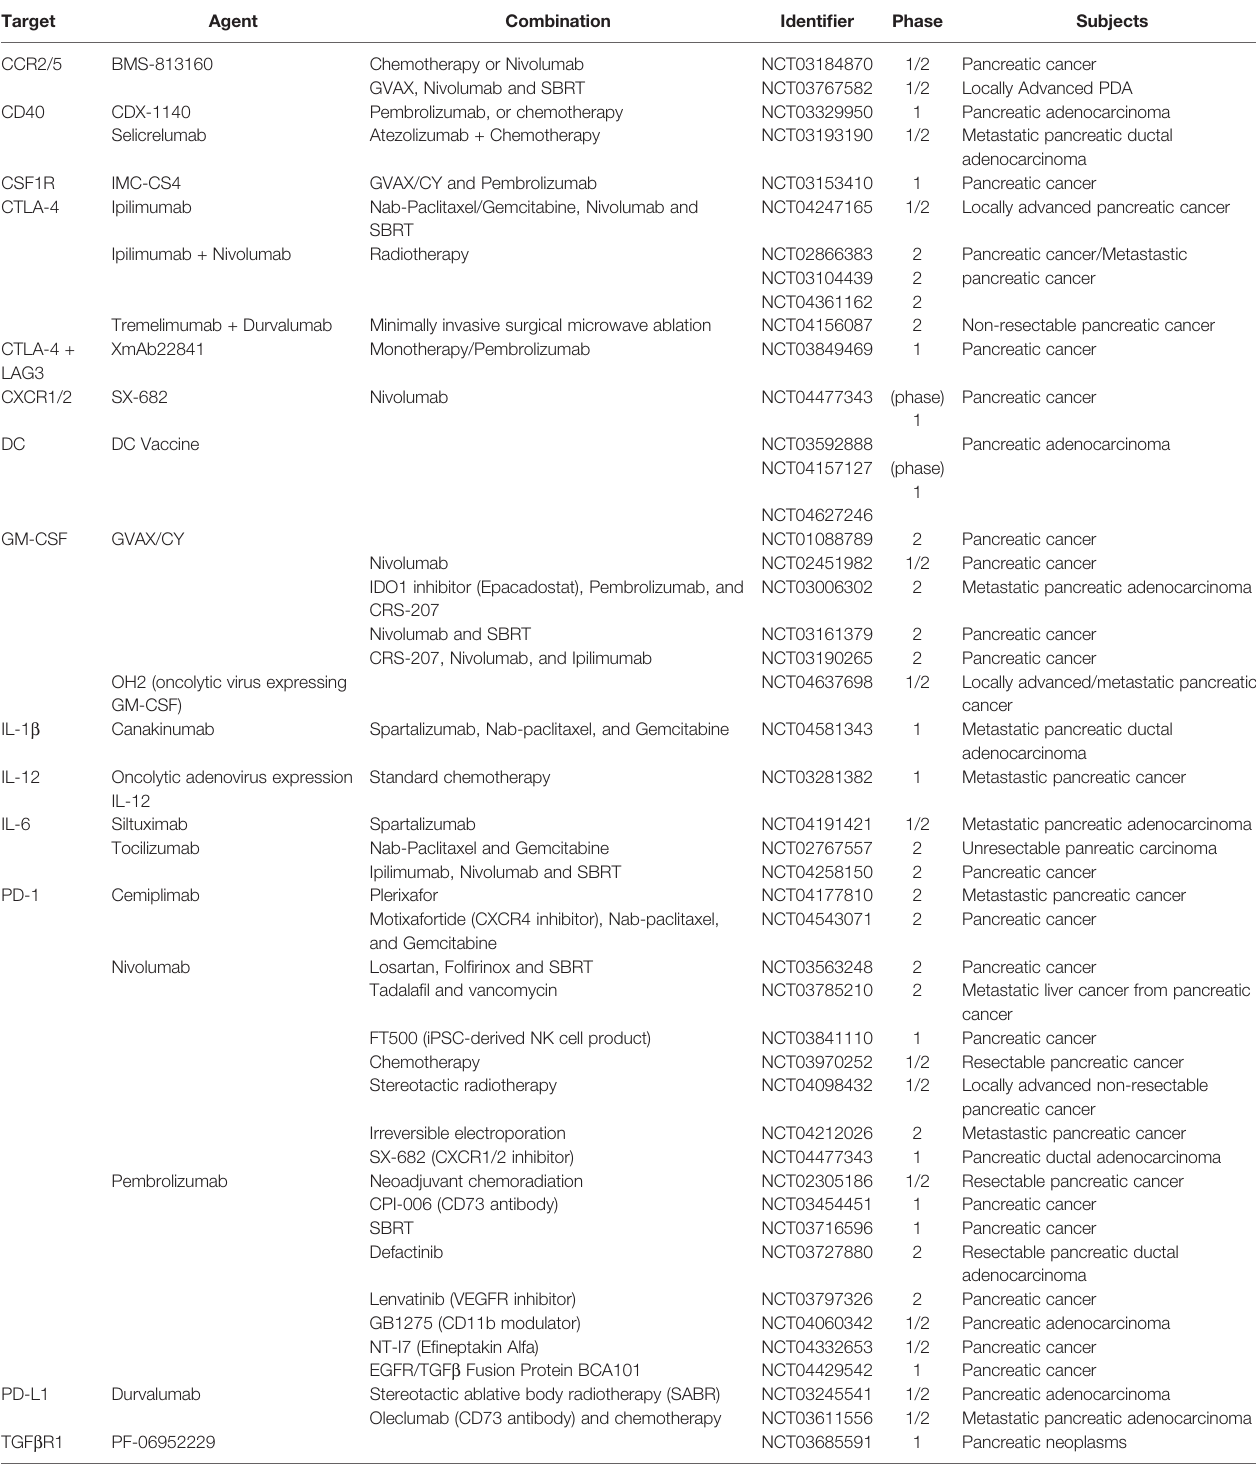
TABLE 1 | Currently active clinical trials targeting the microenvironment of